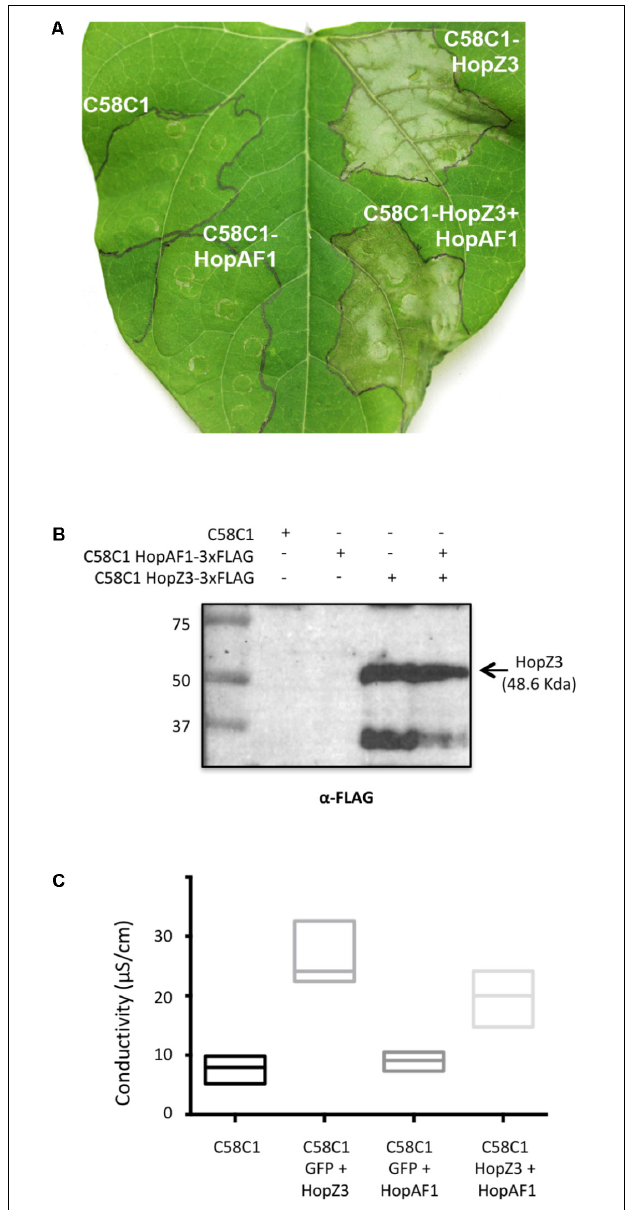
FIGURE 6 | HopAF1 displays suppression activity of HopZ3-triggered immunity in bean. (A) Plant response displayed in bean leaves inoculated with Agrobacterium tumefaciens C58C1 carrying either or both binary plasmids encoding HopAF1-3xFLAG and HopZ3-3xFLAG. Where two effectors are indicated leaves were infiltrated with a 1:1 mixture of A. tumefaciens C58C1 carrying the plasmids encoding each of the indicated effectors. Pictures were taken 48 h post-inoculation. The experiment was repeated three to five times with similar results. (B) Western blot analysis of samples taken from bean leaves described in (A) using an anti-FLAG antibody. (C) Conductivity assays on bean leaves inoculated with A. tumefaciens C58C1 or C58C1 carrying binary plasmids encoding GFP-3xFLAG, HopAF1-3xFLAG, or HopZ3-3xFLAG. Where two effectors are indicated leaves were infiltrated